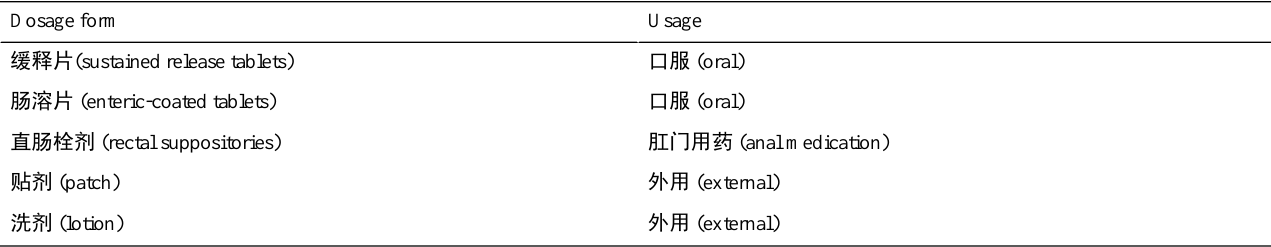
Table 3. Mapping table of the dosage form to